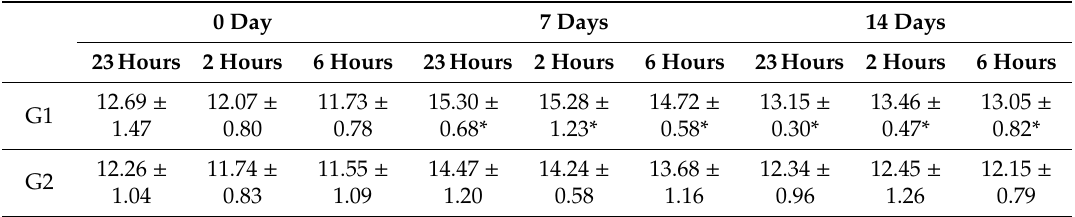
Table 6. Summary of animal experiments (unit: ng /